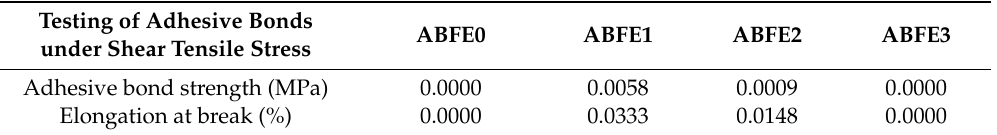
Table 5. Statistical testing of adhesive bonds—adhesive bond shear strength and elongation at break after cyclic loading 5–30% (165–989 N).